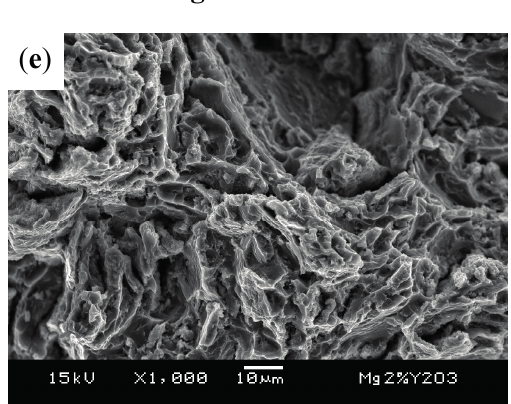
Figure 8. Representative SEM micrographs of the tensile fracture surface for: ( a )